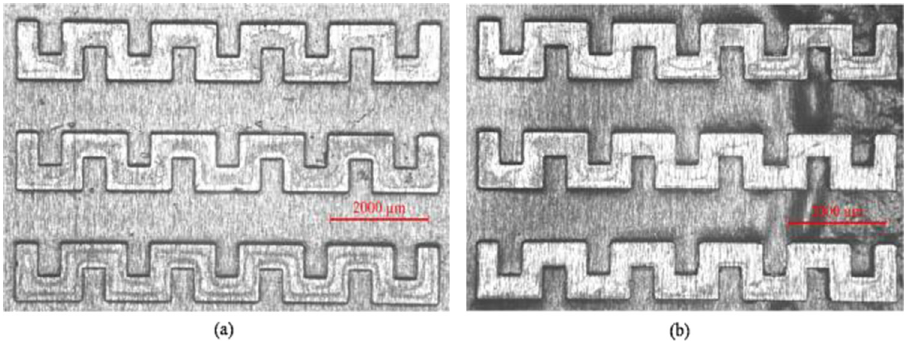
Fig. 9. (a) Unused mask and (b) mask after being used 26